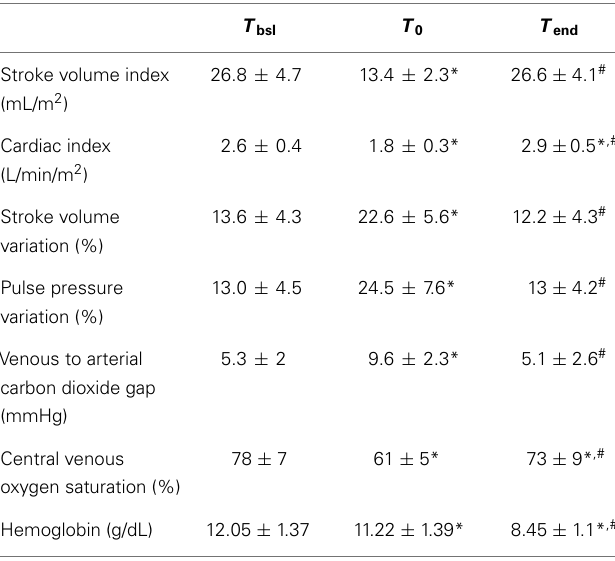
Table 1 | Hemodynamic and blood gas changes during stroke volume based fluid